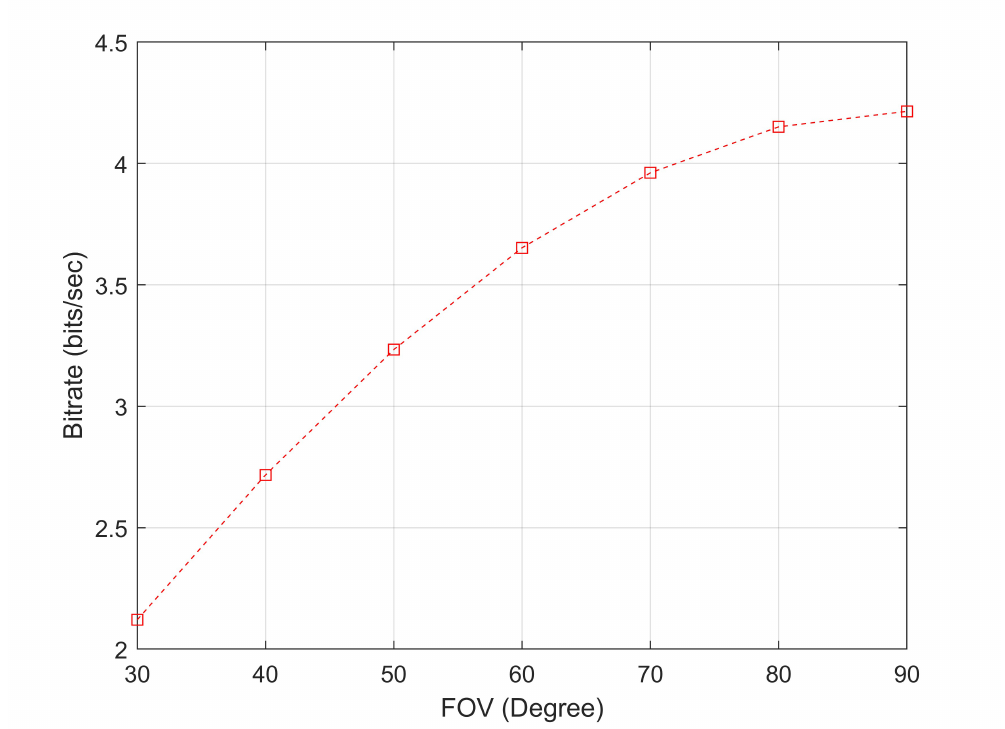
Figure 21. FOV effect on bitrate